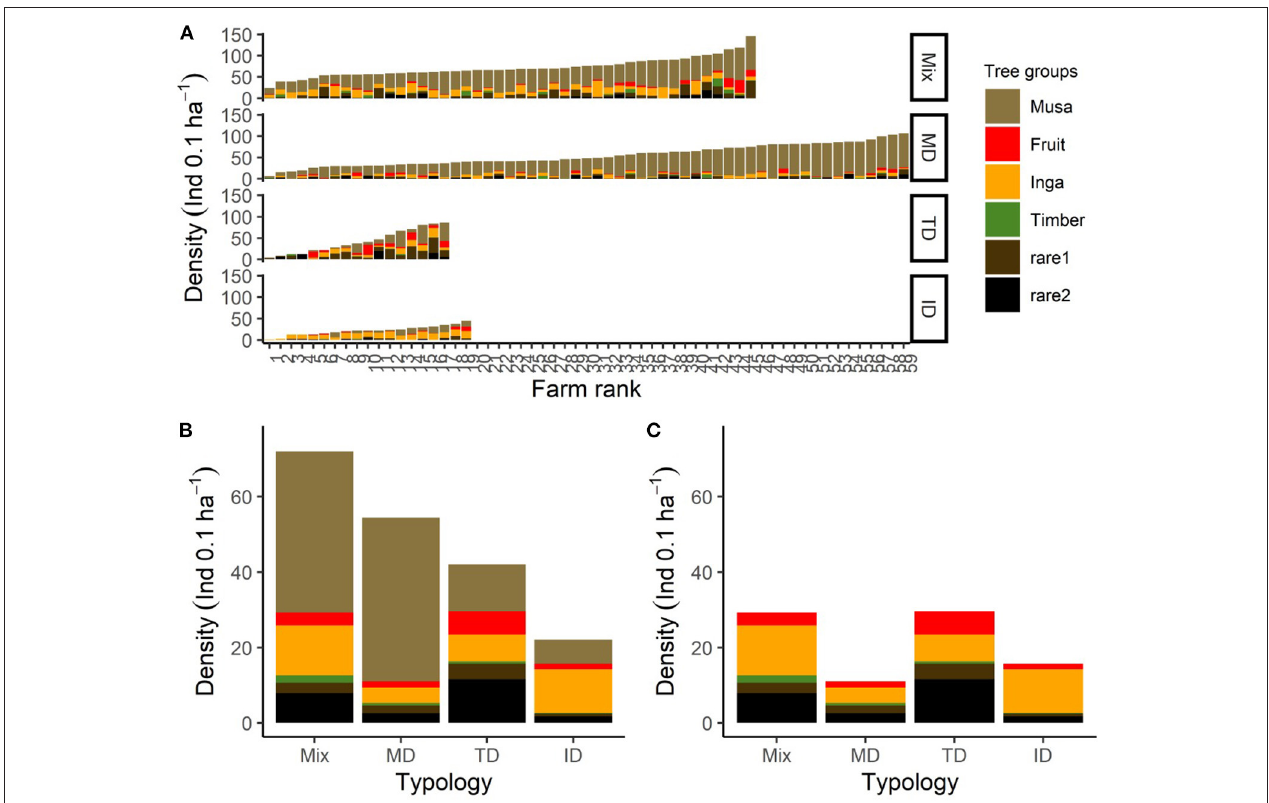
FIGURE 2 | (A) Tree composition for each of 140 plots by typology MD, ID, TD, MIX. (Fruit = fruit trees found in > 20 plots— Persea americana , Citrus spp, Mangifera indica , Psidium guajava , Timber = timber species found in > 20 plots— Juglans olanchana , Cordia aliadora , rare1 = species found in 9–20 plots, including less common timber and native fruits, rare2 = species found in fewer than 9 plots, including less common timber and native fruits). (B) Average density and composition for each typology including Musa. (C) Average density and composition for each typology without Musa.